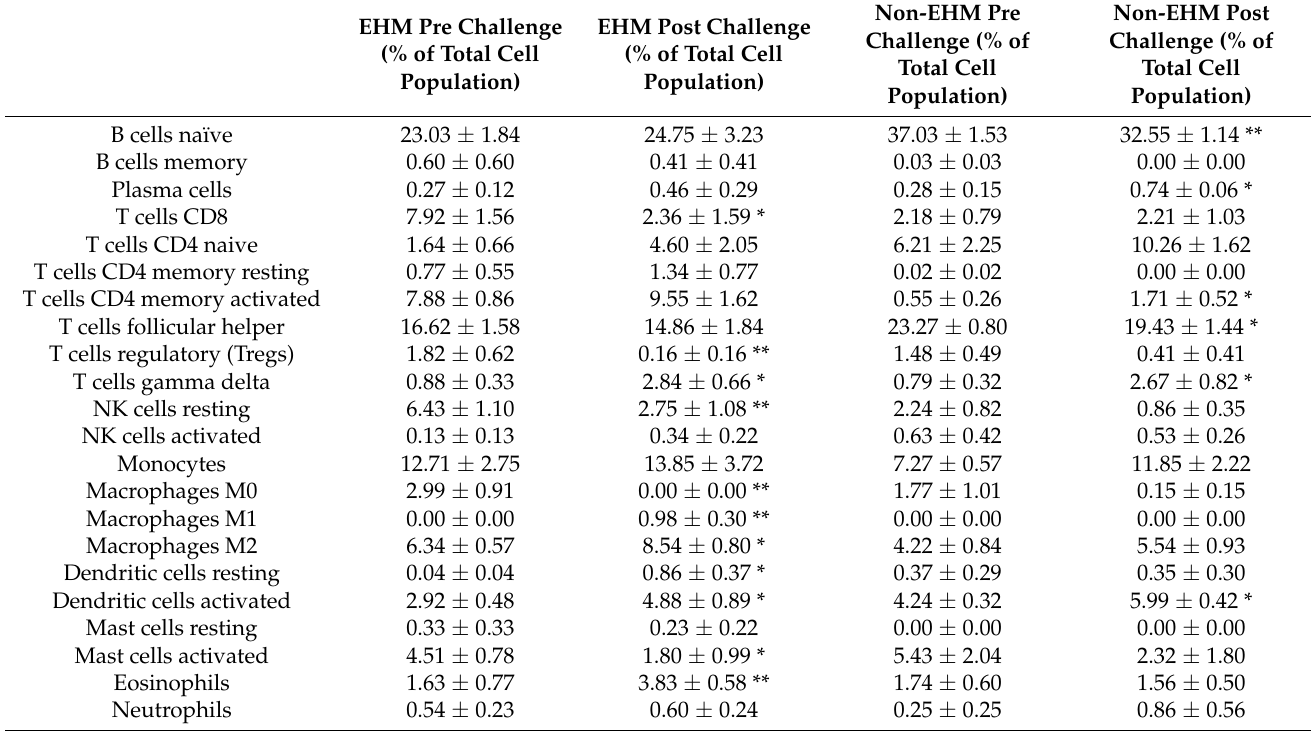
Table 2. Average fractions of cell populations in PBMCs. Cell population fractions for each sample were estimated using CIBERSORTx [52] and the reference gene signature “LM22” included with the software, which is based on the transcriptome of human PBMC samples with predetermined cell populations. Wilcox signed-rank test was performed on the paired samples for each group * indicates a significant difference at p ≤ 0.1, and ** indicates p ≤ 0.05 in cell fraction between pre CH and post CH samples for each group (EHM and